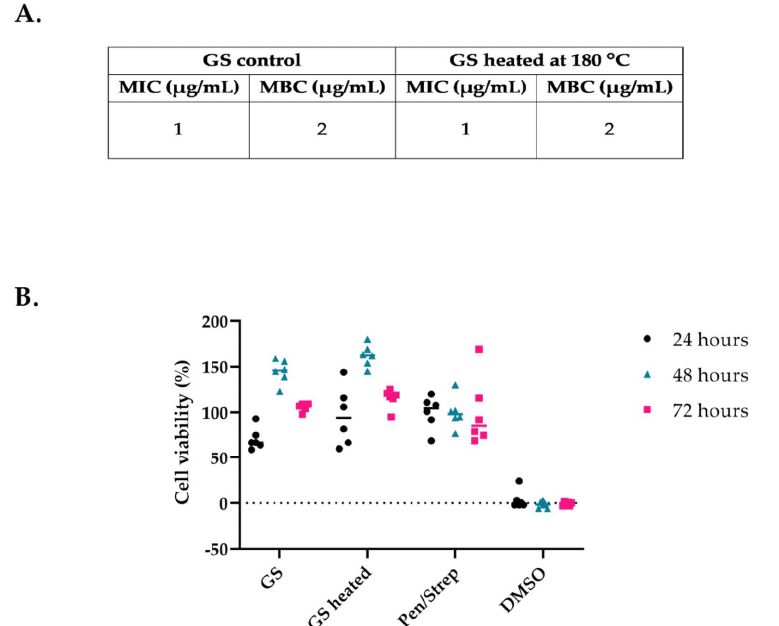
Figure 6. MIC/MBC of non-heated GS and GS heated at 180 ◦ C for S. aureus JAR 06.01.31 ( A ). Percentage of L929 mouse fibroblast cell survival after 24, 48 and 72 h exposure to non-heated GS, heated GS, DMEM medium with Pen/strep as a negative and DMSO (10%) as a positive control for cytotoxicity ( B ). Note: DMEM medium with Pen/Strep is set at 100% cell survival ( n = 6).